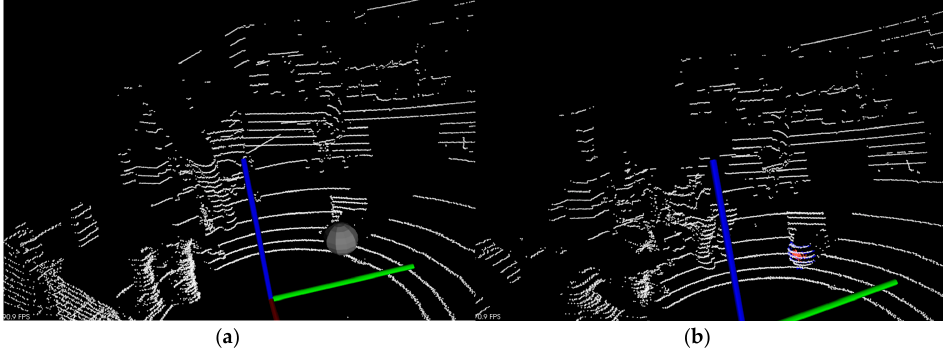
Figure 14. The tracking results in interference scenes: ( a ) Results with Kalman filter; ( b ) Results with adaptive particle filter.